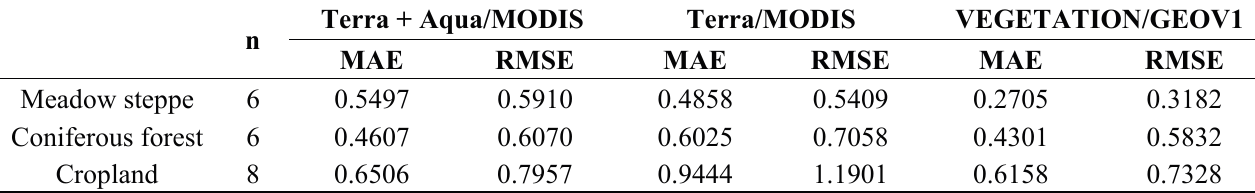
Figure 3. Evaluation of the LAI products using LAI reference maps: ( a ) Terra MODIS; ( b ) Terra + Aqua MODIS; and ( c ) VEGETATION GEOV1. Table 4. MODIS and GEOV1 comparisons with LAI reference